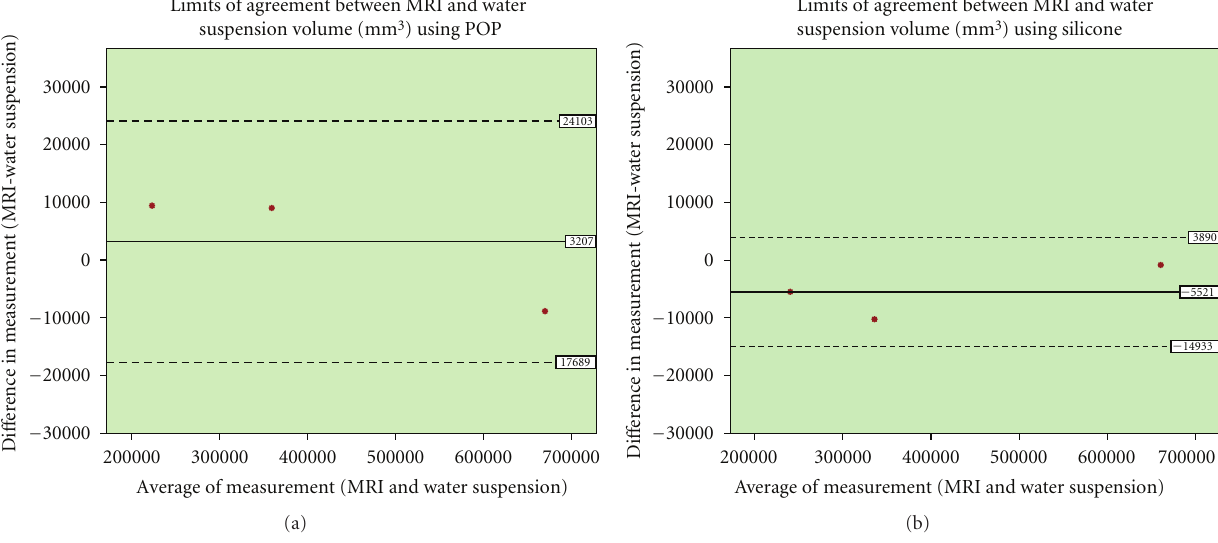
Figure 9: Bland and Altman plot for the volume measurement comparison of MRI and water suspension, (a): POP and (b): silicone.